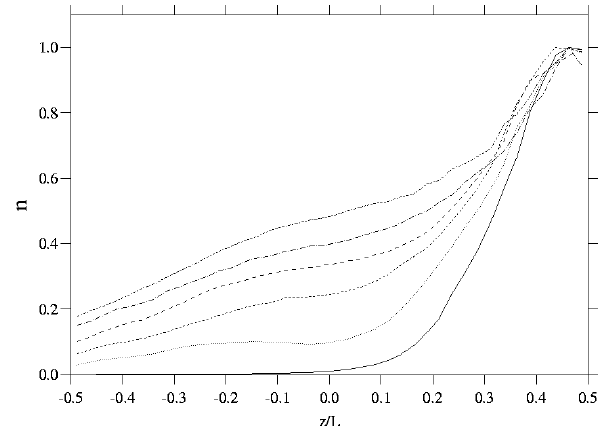
Fig. 9. The same as in Figs. 6–8 for all types of trajectories and b y = 1.